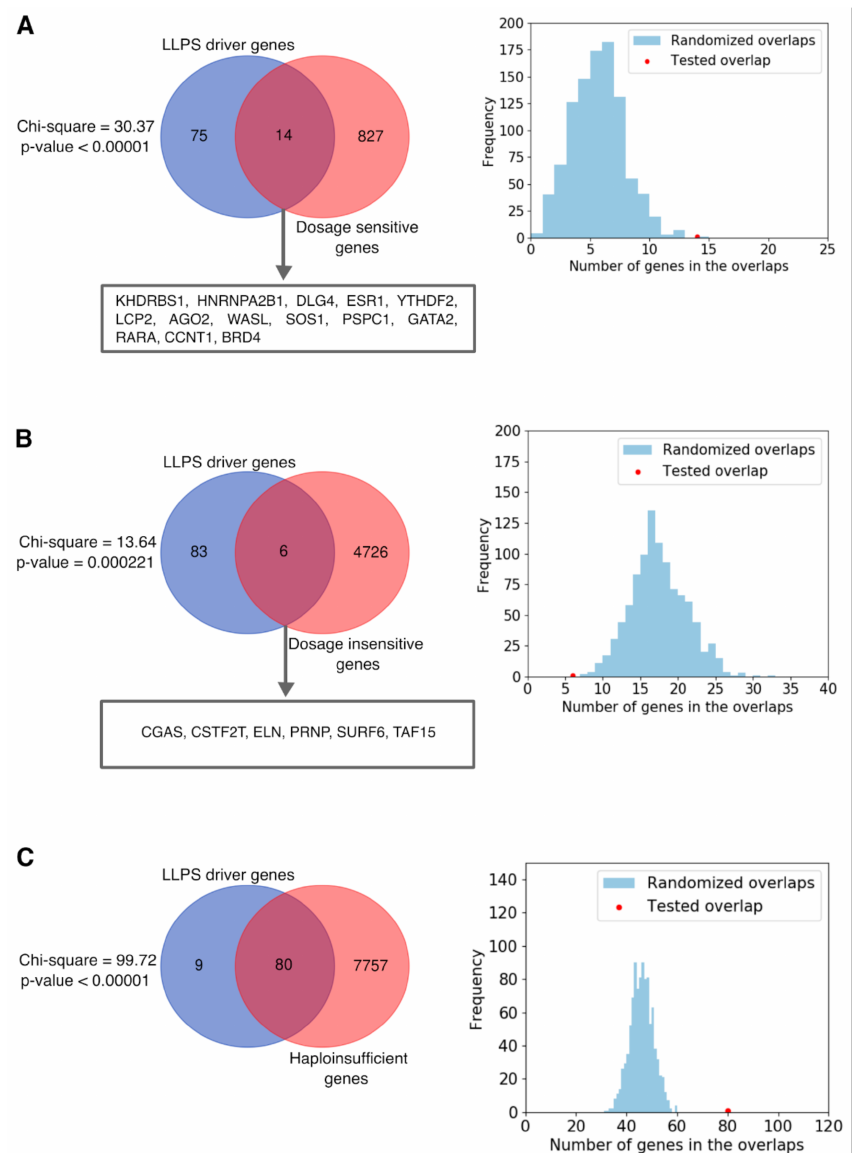
Figure 5. The genes of human LLPS drivers are overrepresented in dosage-sensitive genes. The Venn diagrams (left) show the overlap between human LLPS driver genes and the set of most reliable dosage- sensitive (MRDS) genes ( A ), the set of most reliable dosage insensitive (MRDIS) genes ( B ), and the set of haploinsufficient genes ( C ). The genes in the intersections are listed for ( A , B ). The detected overlaps represent statistically highly significant enrichments ( A , C ) or depletion ( B ) based on chi 2 tests using the whole human-reviewed UniProt proteome as background. Histograms (right) showing the difference between the overlaps of human LLPS-associated genes (red) or equivalent sets of randomly selected well-annotated genes (blue) with ( A ) MRDS, ( B ) MRDIS, and ( C ) haploinsufficient